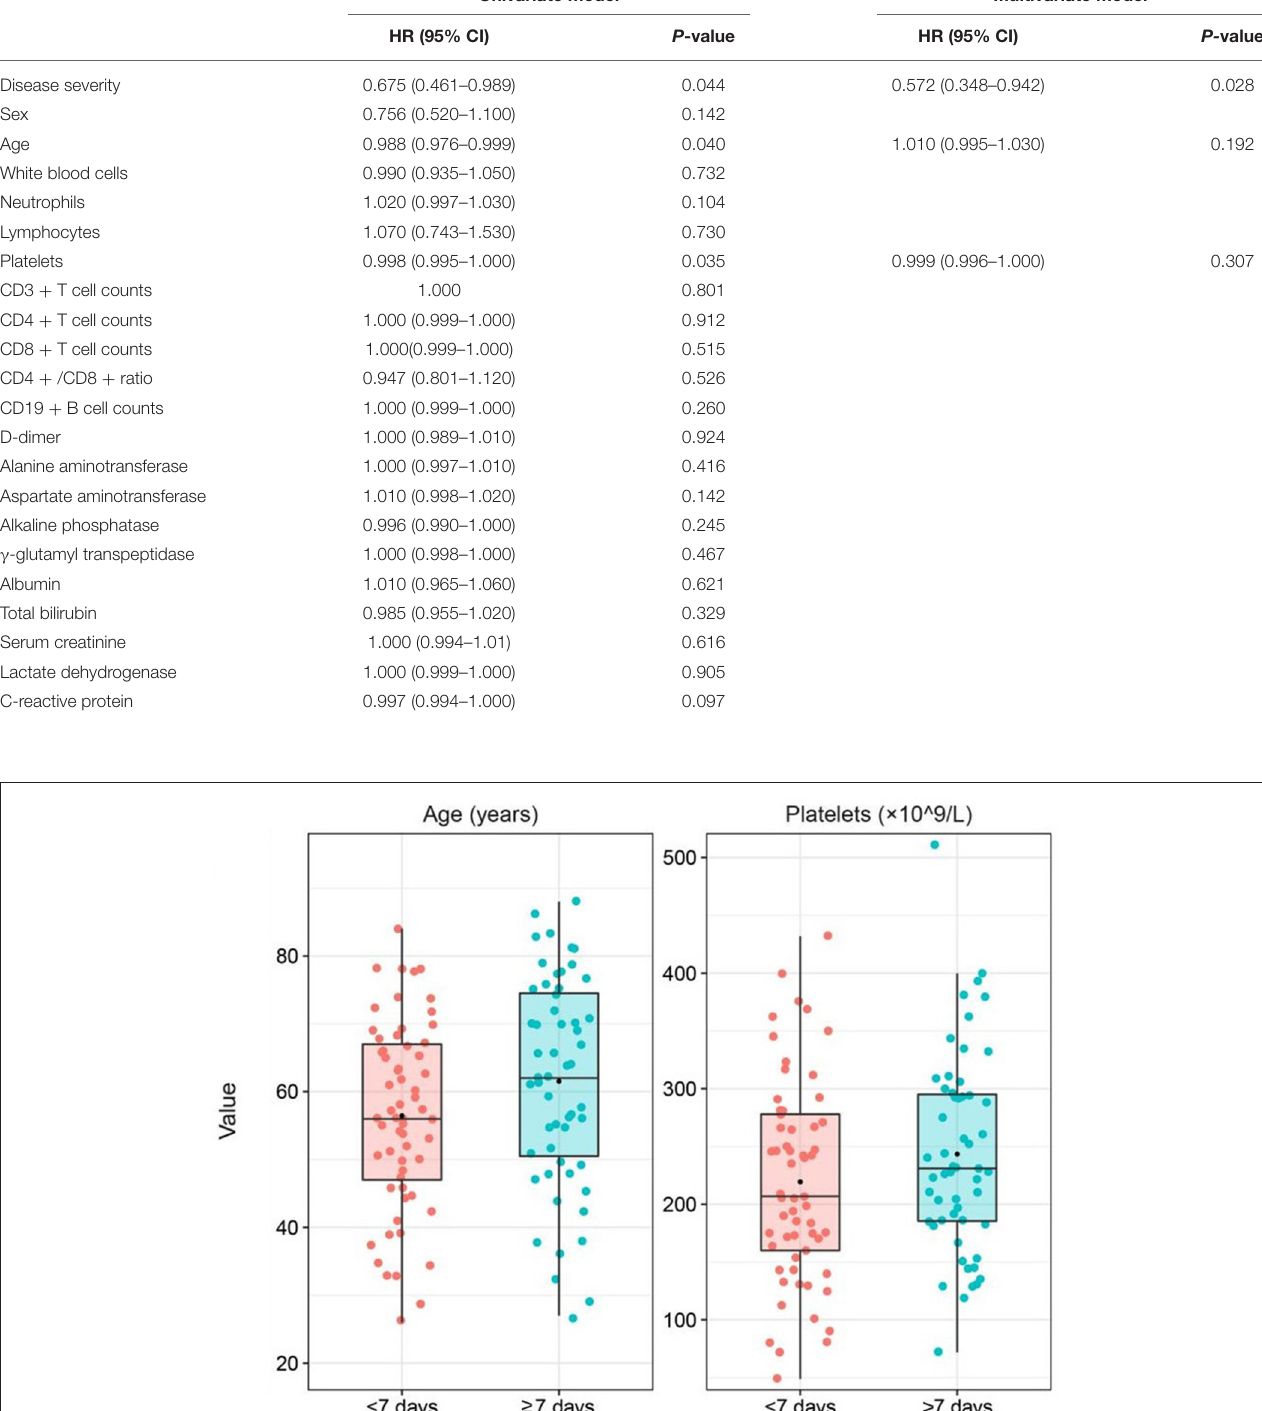
Frontiers in Medicine |